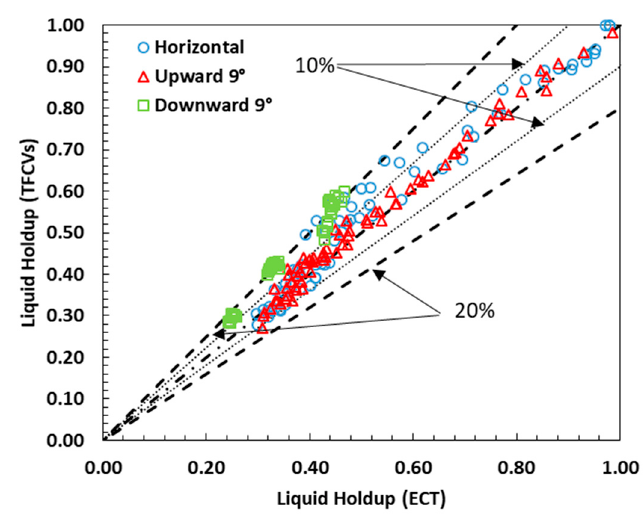
Figure 7. Validation of ECT ε (L) against the TFCV for all condition.